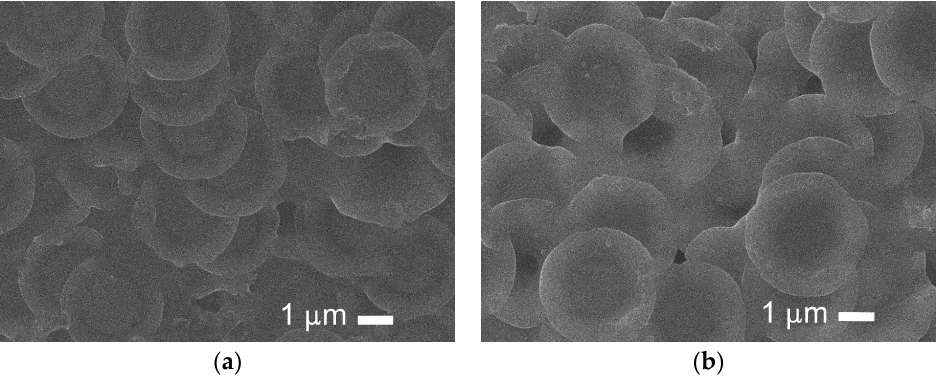
Figure 2. SEM images measured for the coatings on the working surface of RS blades after the commutation test with I c = 0.4 A and 10 6 switching cycles: ( a ) cathode; ( b ) anode.